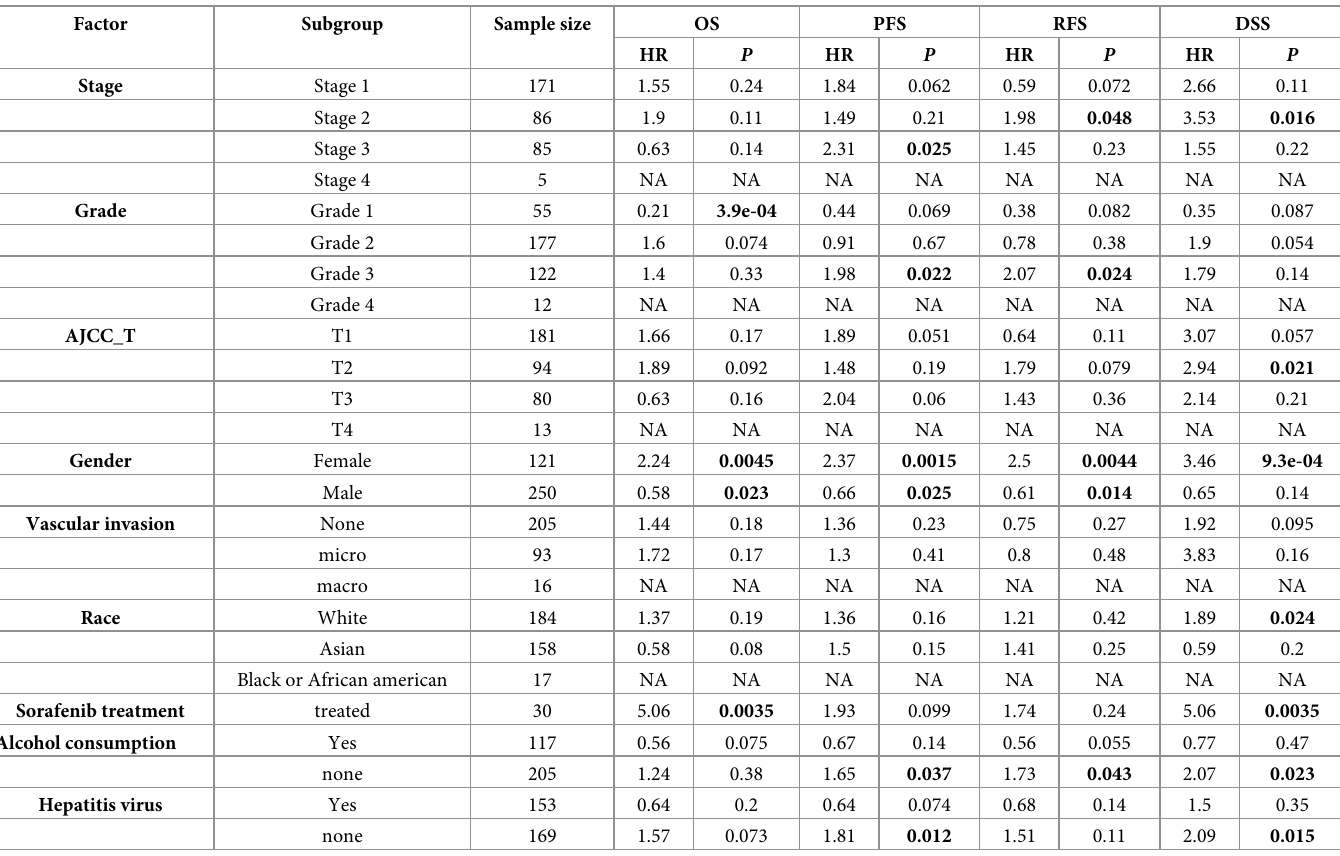
Table 5. Subgroup analysis on the correlation of SMARCA1 expression and prognosis of liver cancer cases. Factor